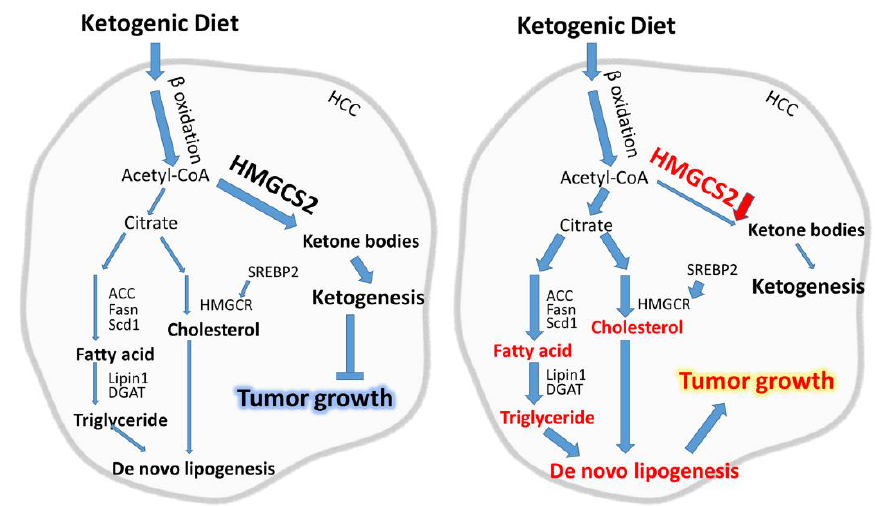
Figure 7. HMGCS2 downregulation increased de novo lipogenesis, which reversed the antitumor effect of a KD. In HCC tumors with HMGCS2 expression (left panel), KD supplementation increases ketogenesis mediated by HMGCS2, and therefore, inhibits HCC tumor growth. In the absence of HMGCS2 (right panel), the HCC tumors will be under the condition of ketogenic insufficiency. Under this circumstance, the use of a KD will increase de novo lipogenesis and ultimately trigger HCC tumor growth.